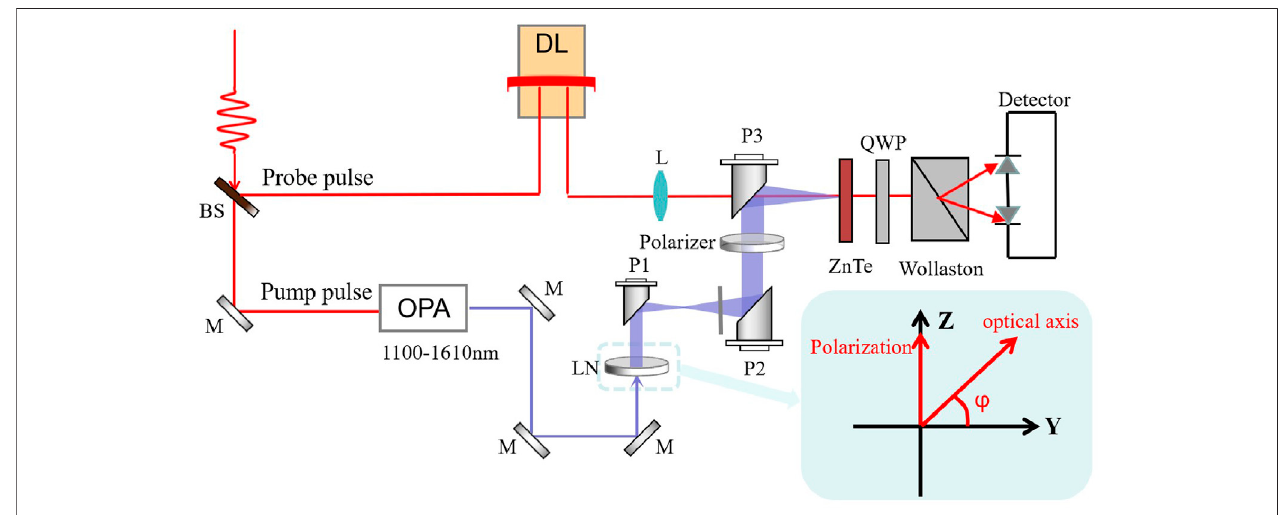
FIGURE 2 | Experimental setup for THz electric fi eld generation and detection. BS: beam splitter. OPA: optical parametric ampli fi er. M: fl at laser re fl ection mirrors. LN:300-nmthickx-cutlithiumniobatemetasurface.P 1 ,P 2 ,P 3 :90 ° off-axisparabolicmirrors.Polarizer:thin- fi lmwire-gridTHzpolarizer.DL:delayline.L:lenswithafocal length of 300 mm. ZnTe: 1-mm thick (110)-cut ZnTe crystal. QWP: quarter-wave plate. Wollaston: Wollaston prism. Detector: balanced photodiode detector. The inset shows the optical axis of the x-cut LiNbO 3 metasurface in the experimental coordinate system. The x -axis is the reverse of the propagation direction of pump pulses. z -axisisverticalandalongthepolarizationdirectionofpumppulses. φ istheanglebetweentheopticalaxisandhorizontal y -axis.TheelementbetweenP 1 andP 2 is the Te fl on board, which is used to transmit the THz waveform and block the pump